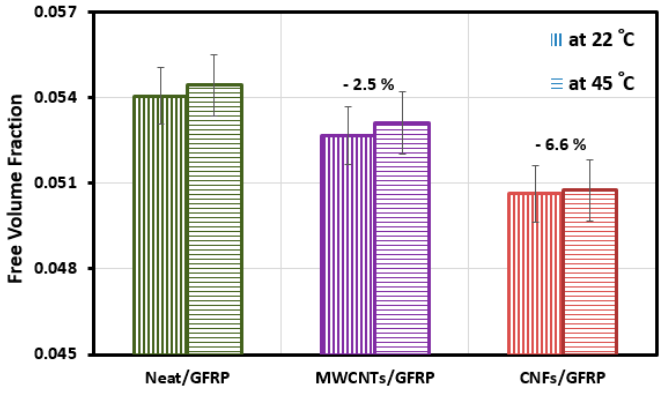
Figure 9. Interfacial free volume fraction for Neat/GFRP, MWCNTs/GFRP, and CNFs/GFRP composites at temperatures 22 and 45 °C.